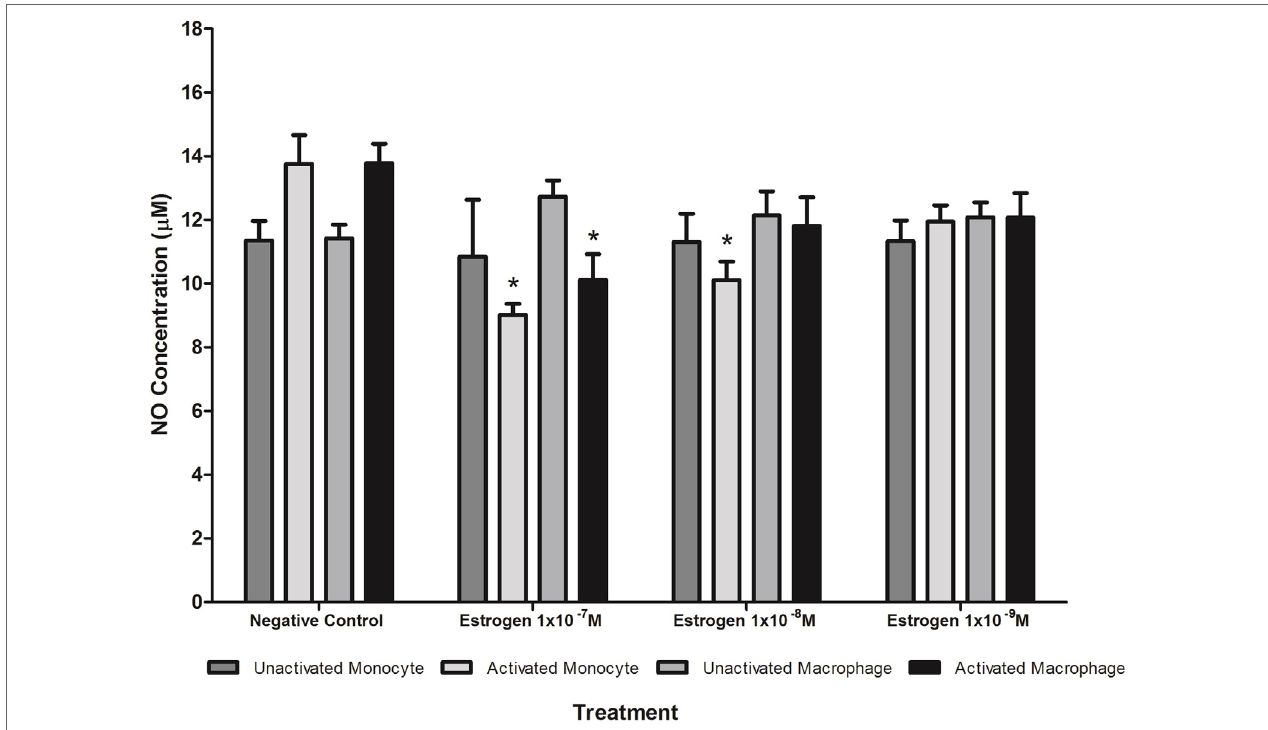
FigUre 6 | Effect of estrogen on nitric oxide (NO) production. Estrogen reduced NO production by lipopolysaccharide (LPS)-activated U937 monocytes and macrophages. * denotes a significant ( P < 0.05; n = 12) difference in NO production followed by treatment with estrogen (1 × 10 − 7 1 × 10 − 8 , or 1 × 10 − 9 M) compared to the negative control. Errors bars represent the